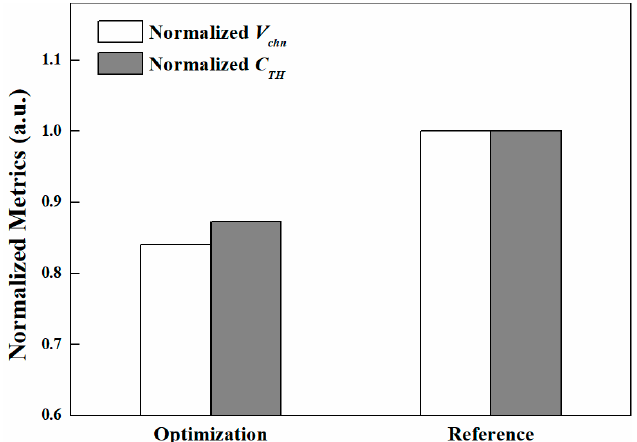
Figure 12. Relation between the channel volume ( V chn ) and C TH for the optimization and reference GAAFET structures.